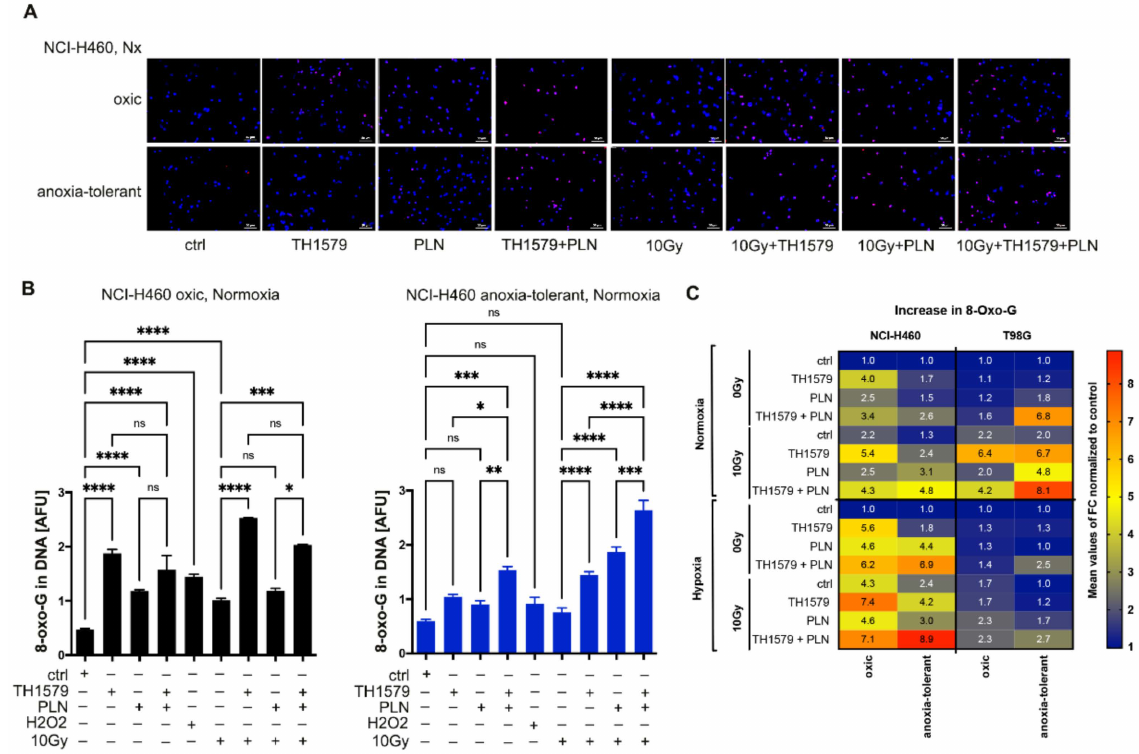
Figure 4. Inhibition of MTH1 alone and combined with inhibition of glutathione regeneration leads to increased oxidative DNA damage, especially in acute hypoxia. Effect of IR and/or acute hypoxia on formation of oxidative DNA damage in oxic and anoxia-tolerant NCI-H460 cells and the alterations upon 24 h of treatment with PLN and TH1579 were investigated. ( A ) Representative micrographs of 8-oxo-G formation in NCI-H460 oxic and anoxia-tolerant cells treated under normoxic conditions analyzed by fluorescence microscopy. Scale bars display 50 µ m. ( B ) Bar graphs indicating arbitrary fluorescence units (AFU) of 8-oxo-G of oxic (left panel) and anoxia-tolerant (right panel) NCI-H460 cells in nucleus area ( C ) Heatmap indicating fold changes of 8-oxo-G formation in NCI-H460 or T98G oxic and anoxia-tolerant cells under different treatments compared to untreated controls under normoxic and severe hypoxic conditions. Bar graphs with measured AFU used to calculate FC can be found in Supplementary Materials Figure S3. Mean values ± SEM are shown, n = 3 (* p ≤ 0.05, ** p ≤ 0.01, *** p ≤ 0.001, **** p ≤ 0.0001; t